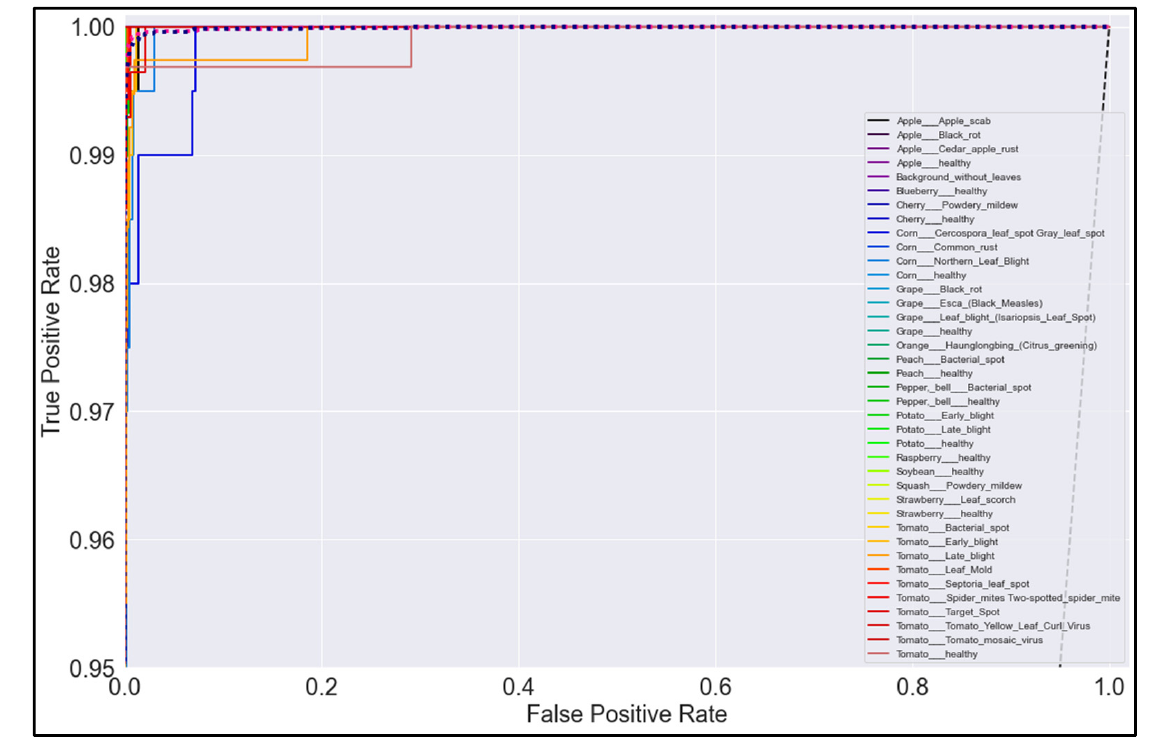
Figure 22. ROC Curve for MobileNet model with transfer learning Scenario 4 and Proposed hyperparameters.